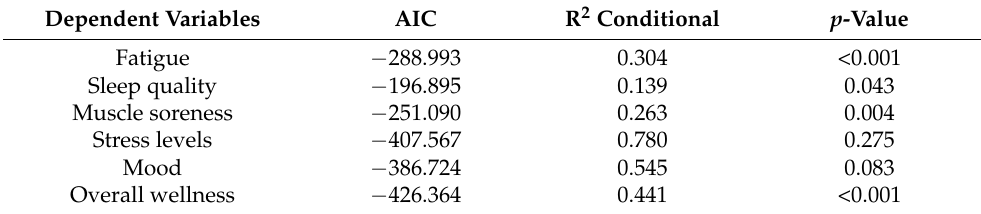
Table 2. Day-to-day changes in well-being